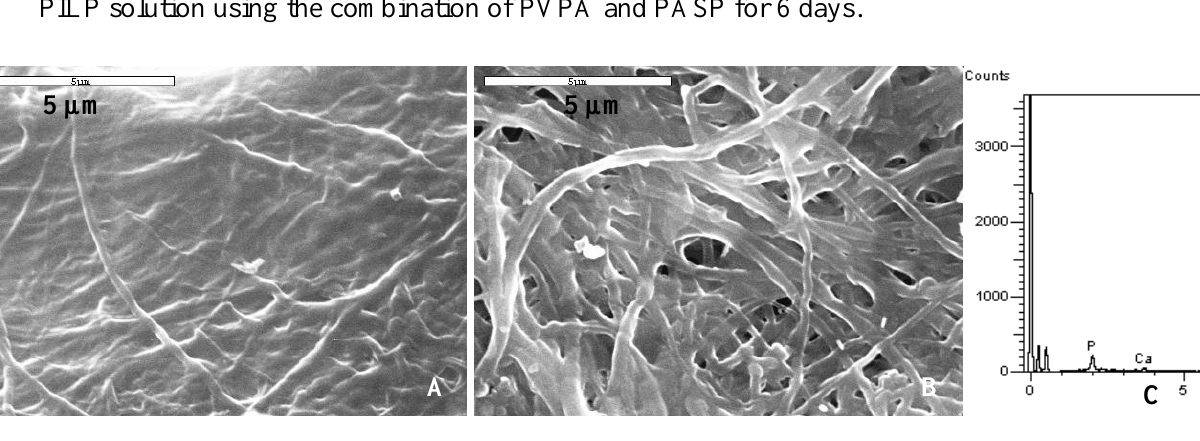
Figure 7. High-magnification SEM and EDS of the surface of PILP-mineralized collagen samples using 24-kDa polyvinylphosphonic acid (PVPA), and a combination of PVPA and PASP as the polymer directing agents. ( A ) SEM showing the surface of a mineralized collagen sponge treated with PILP solution containing 1,000 µg/mL PVPA for 6 days. ( B ) SEM showing the surface of a sample treated with PILP solution containing a combination of 1,000 µg/mL PVPA and 50 µg/mL 14-kDa PASP for 6 days. Corresponding ( C ) EDS of the surface of mineralized collagen sponge treated with the PILP solution using the combination of PVPA and PASP for 6